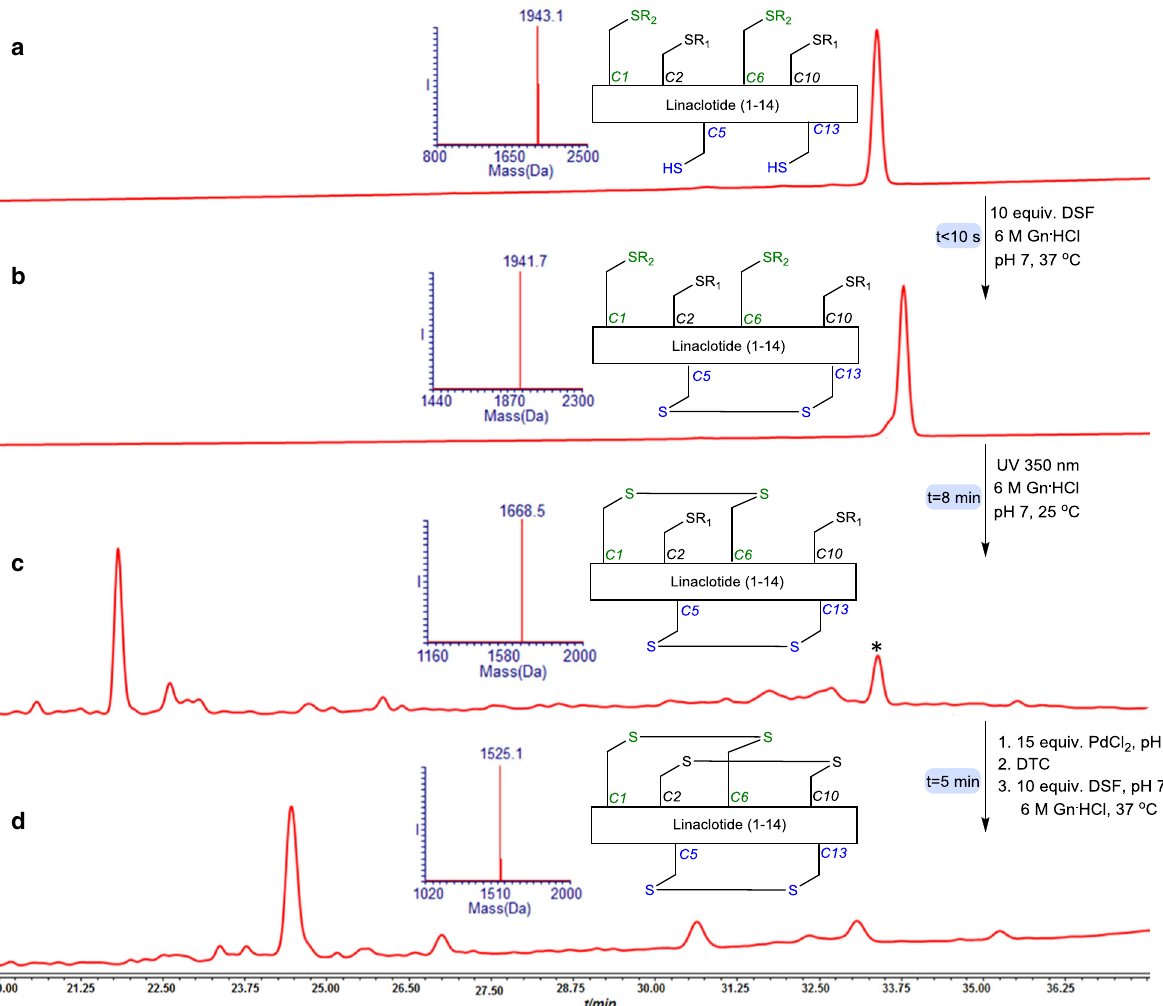
Fig. 5 Linaclotide synthesis. a HPLC-ESI MS analyses: Reaction at time zero, the main peak corresponds to reduced Linaclotide with the observed mass 1943.1 ± 0.1 Da, calcd. 1944.2 Da (average isotopes). b Reaction after 10 s, the main peak corresponds to Linaclotide with single disul fi de bond with the observed mass 1941.7. ± 0.1 Da, calcd. 1941.1 Da (average isotopes). c Reaction after 8 min: the main peak corresponds to Linaclotide with two disul fi de bonds with the observed mass 1668.5 ± 0.2 Da, calcd. 1669.1 Da (average isotopes). d Reaction after 5 min: the main peak corresponds to Linaclotide with the three disul fi de bonds with the observed mass 1525.1 ± 0.1 Da, calcd. 1525.1 Da (average isotopes). R 1 = NBzl, R 2 = Acm. *non peptide mass correspondence to small molecule